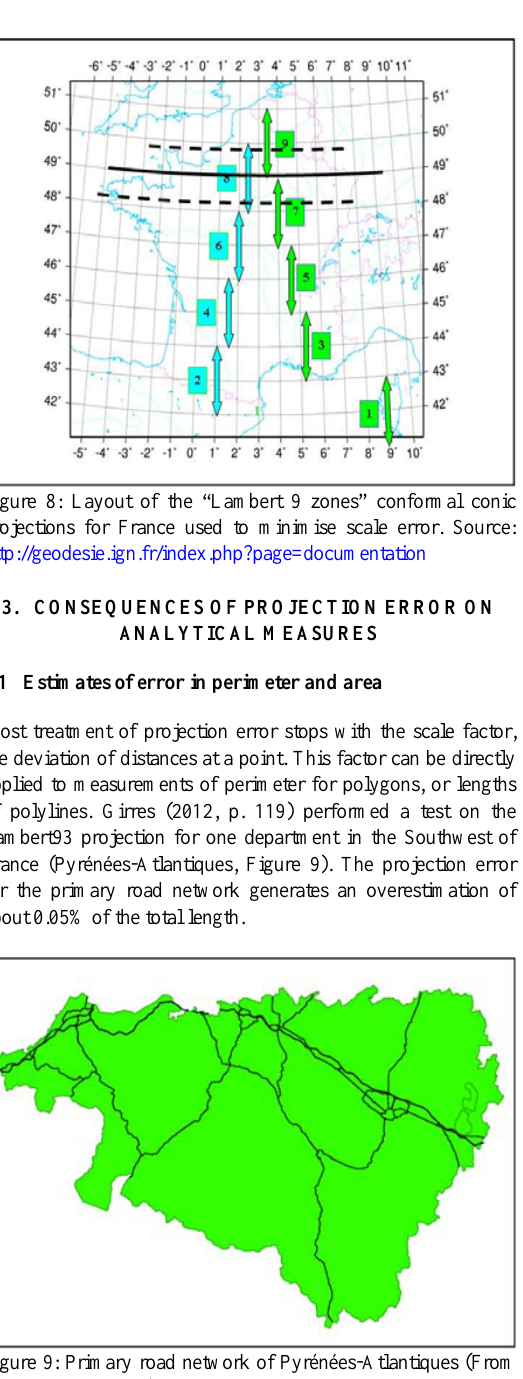
Figure 11: Scale factors differences between RGF Lambert93 Harmel, 2009, p.